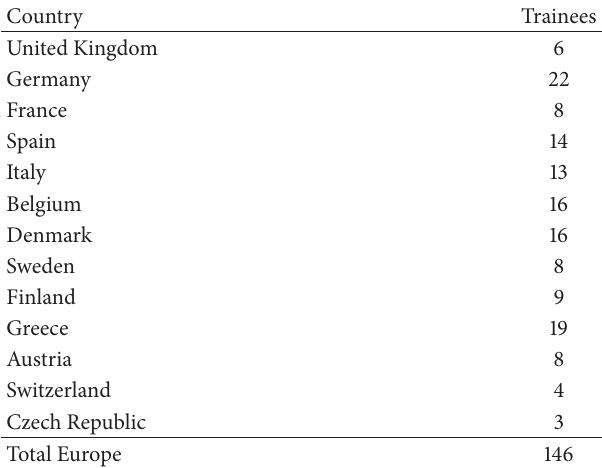
Table 1: Activity for ONSTEP training across Europe 2013. A total of 46 workshops with 146 trainees from 13 different countries have been performed in